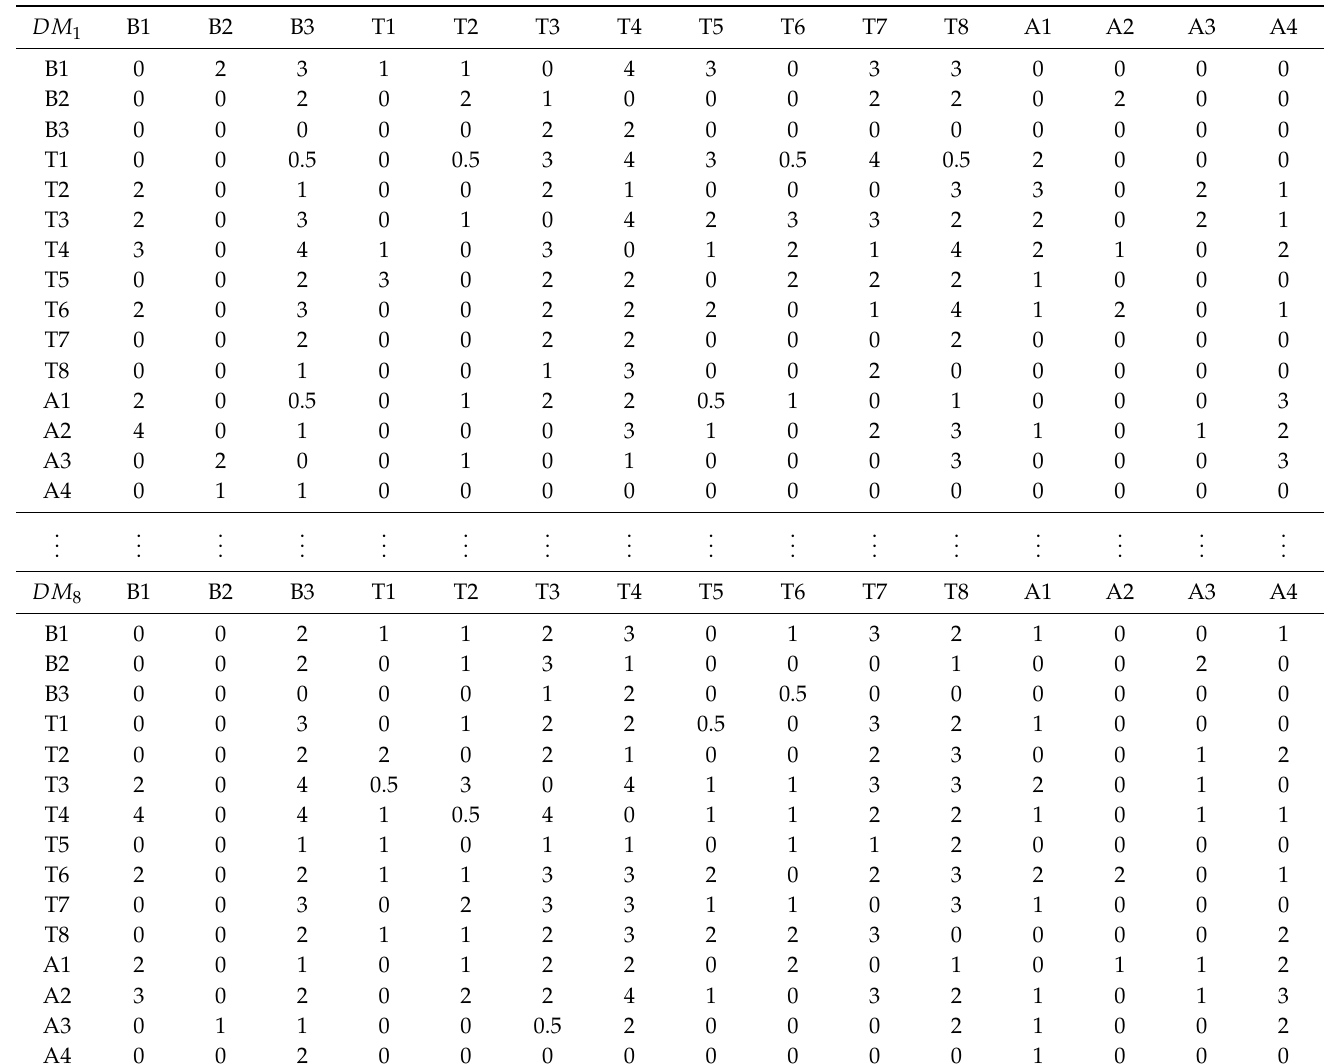
Table A2. The group fuzzy initial direct-relation